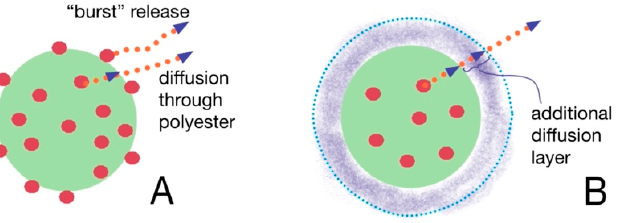
Figure 4. The scheme showing the difference between drug release from non-modified ( A ) and modified ( B ) particles.